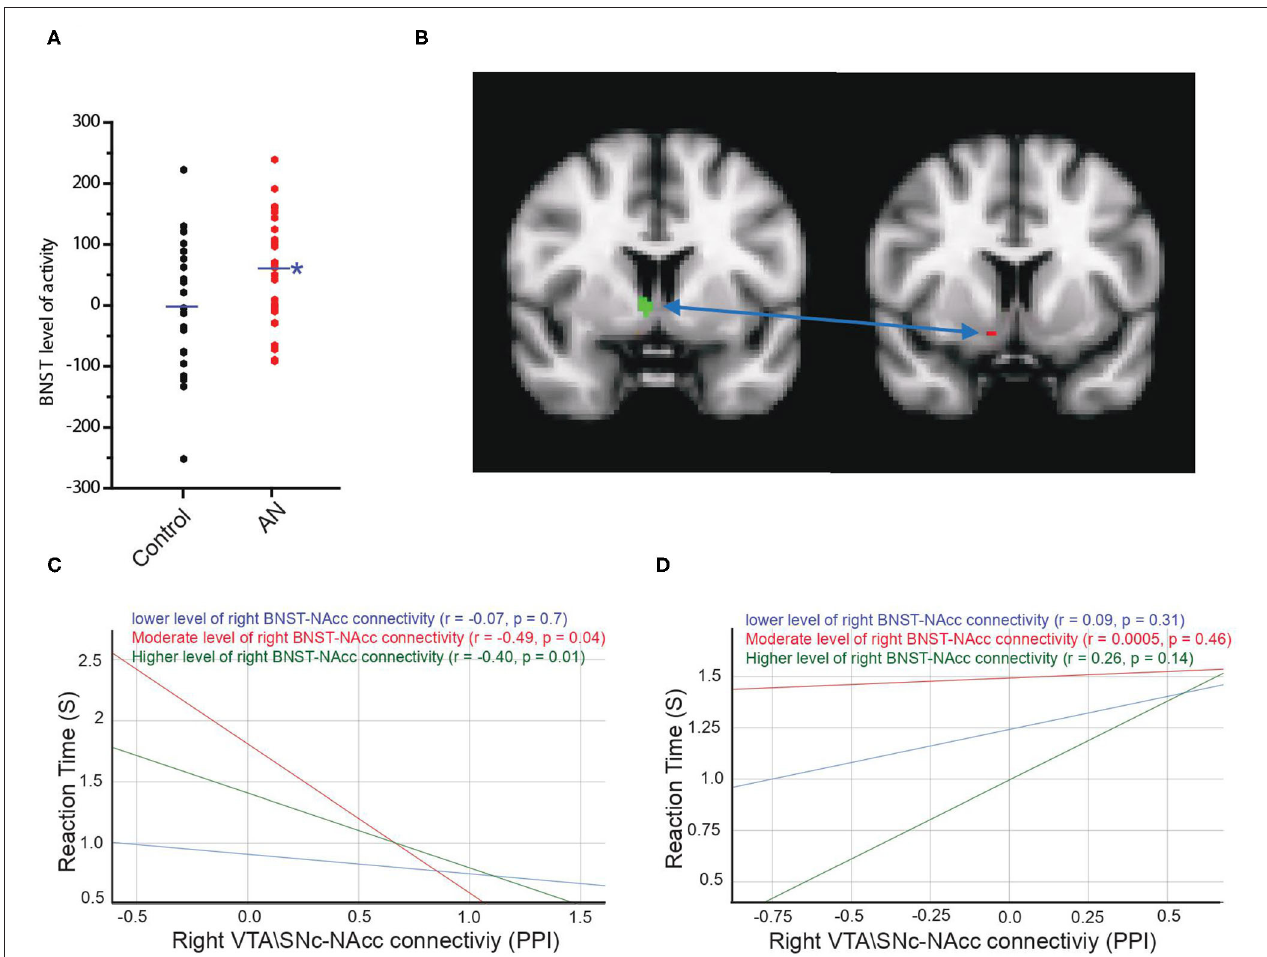
FIGURE 5 | Activity of the bilateral BNST was significantly higher in AN group compared to controls during the reward motivation period (A) . Connectivity of the right BNST ROI (in green) with a cluster in right nucleus accumbens (NAcc) (peak coordinates: 10, 8, − 12, in red) is significantly lower in AN group compared to controls (B) . Moderation results illustrating the association between the right VTA \ SNc-NAcc connectivity during reward motivation period as an independent variable (X) and reaction time as the dependent variable (Y) among control (C) and AN (D) participants with relatively lower (blue), moderate (red) and higher (green) values of the right BNST-NAcc connectivity during reward motivation period. Unlike healthy controls, in AN group there is no significant association between X > Y for any value of the right BNST-NAcc connectivity during reward motivation period. The * symbol indicates statistically